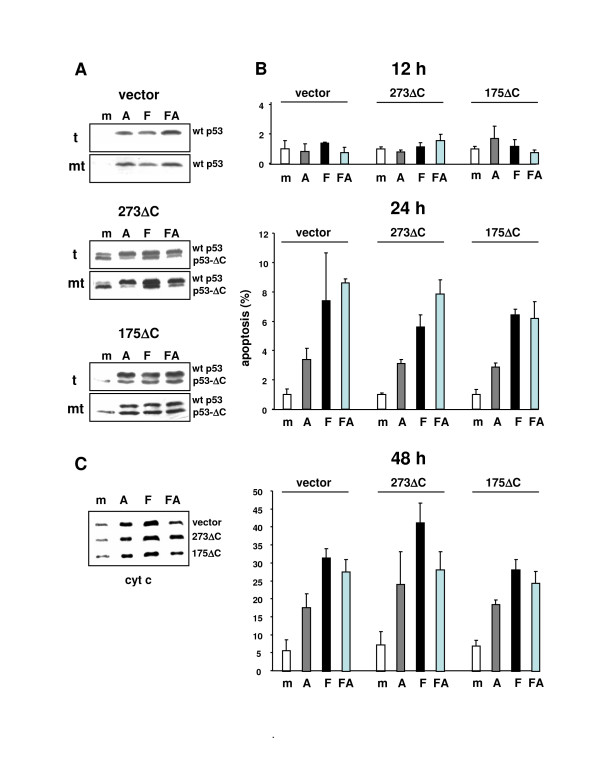
Mitochondrial localization of p53 and apoptosis in HCT116 cells infected to express mutant p53. (A) Western blots on 15 μg of total cellular protein (t) or mitochondrial protein (mt) prepared from the indicated cell lines at 24 h after mock-treatment or exposure to α-amanitin (10 μM; A), 5FU (375 μM; F), or both combined (FA). p53 was detected with anti-p53 antibody DO-1 at a dilution of 1:2000. p53-ΔC: one of the indicated ΔC-forms of mutant p53. (B) Percentage of apoptosis measured by flow cytometry in cultures of the indicated cell lines. The cells were either mock-treated or drug-treated as specified under. Apoptosis at the 12 and 24 h time points (early apoptosis) was determined by measurement of Annexin V binding as detailed in Materials and methods. The apoptosis at 48 h (late apoptosis) was determined by measurement of the cells with a sub-2n DNA content. (C) Western blot on cytoplasm prepared from cultures of the indicated cell lines at 48 h after mock- or drug-treatment. Cytoplasmic accumulation of cytochrome c (cyto c) as a hallmark of apoptosis became apparent after staining of the blot with anti-cytochrome c antibody at a dilution of 1:1000. Vector: HCT116 cells infected with vector-only. 175ΔC: HCT116 cells infected with retroviral vector expressing mutant 175H with a deleted C-terminus. 273ΔC: HCT116 cells infected with retroviral vector expressing mutant 273H with a deleted C-terminus.